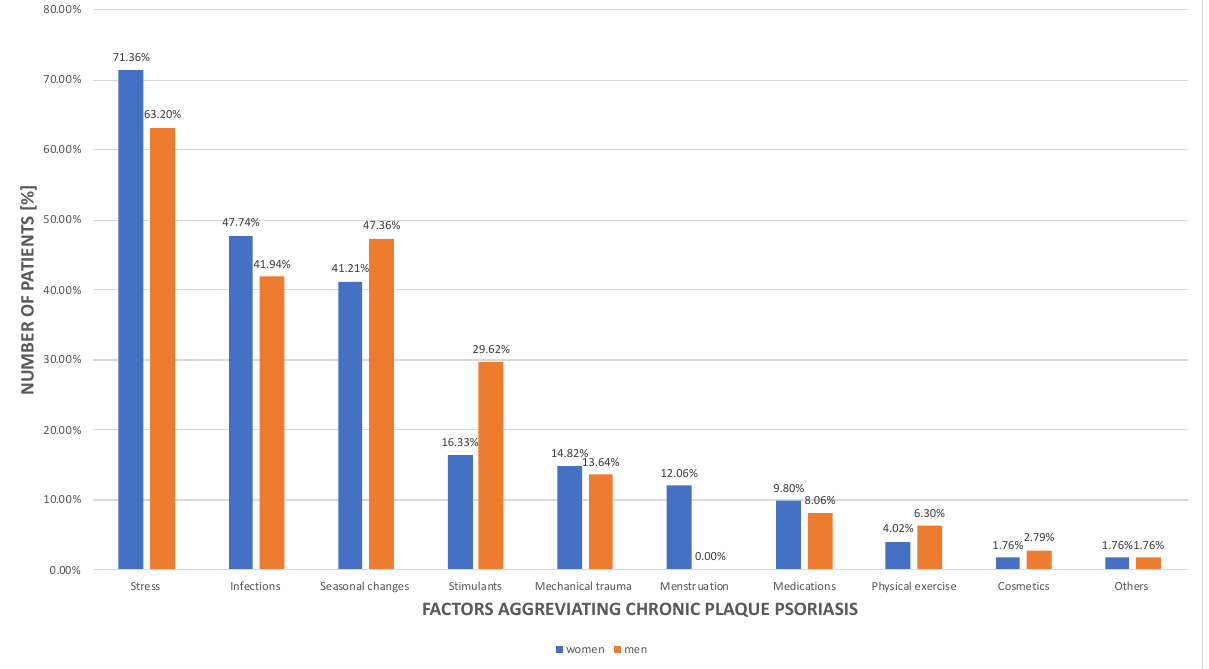
Figure 5. The comparison of concomitant diseases among psoriasis patients and general population. ( A ) Female psoriasis patients vs. female control group. ( B ) Male psoriasis patients vs. male control group.